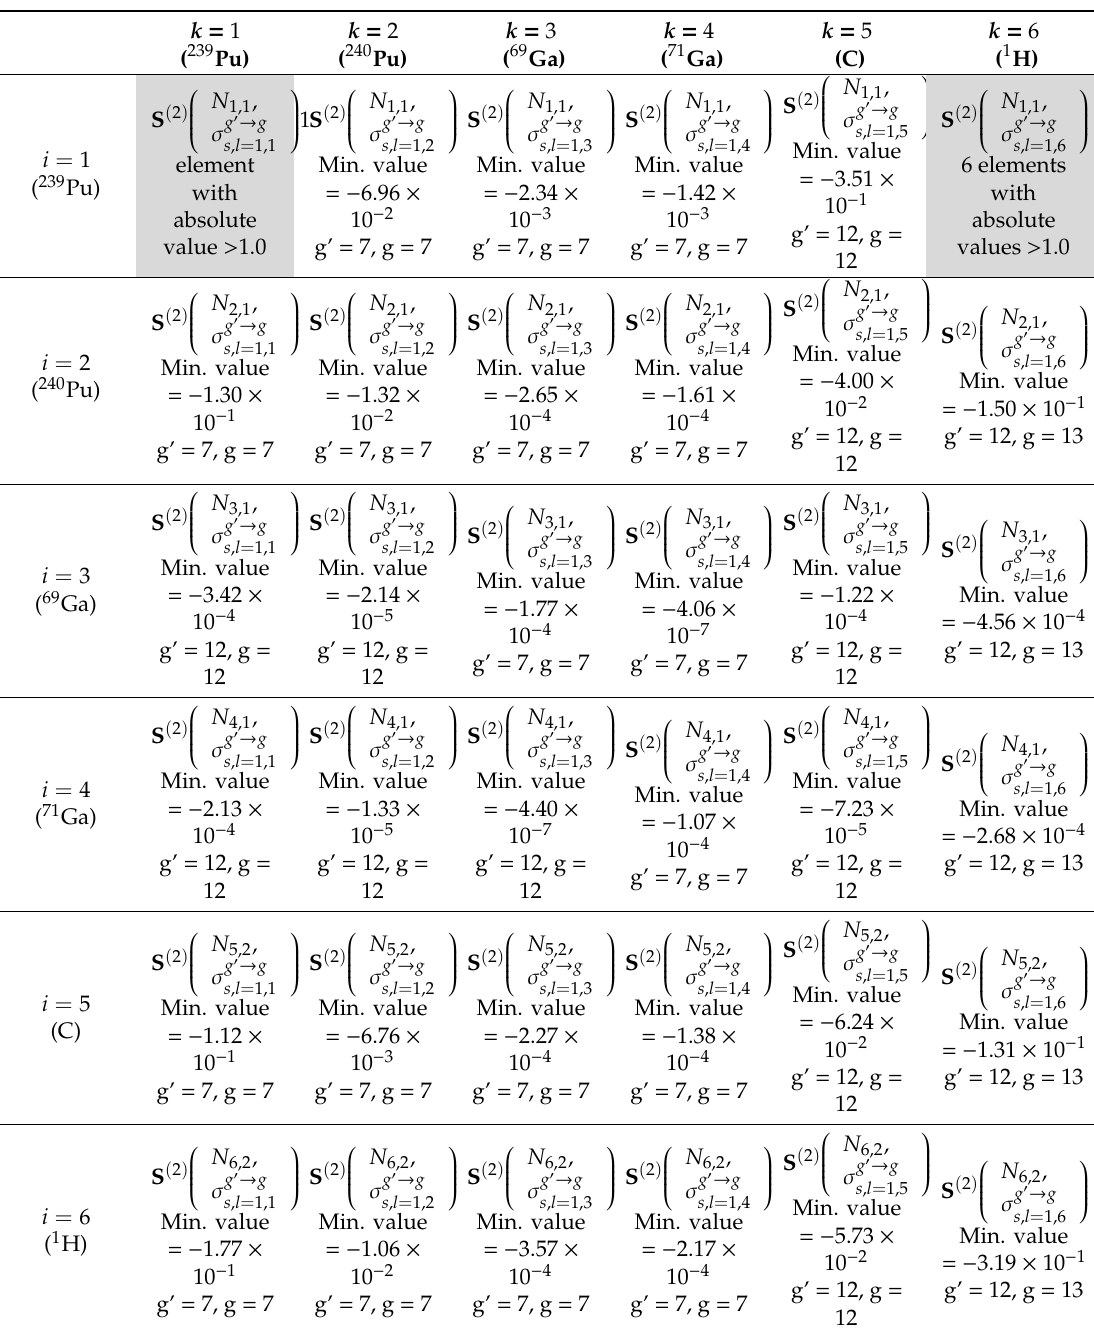
(cid:16) (cid:17) (cid:48) → g N i , m , σ g , comprising the 2nd-order relative s , l = 1, k